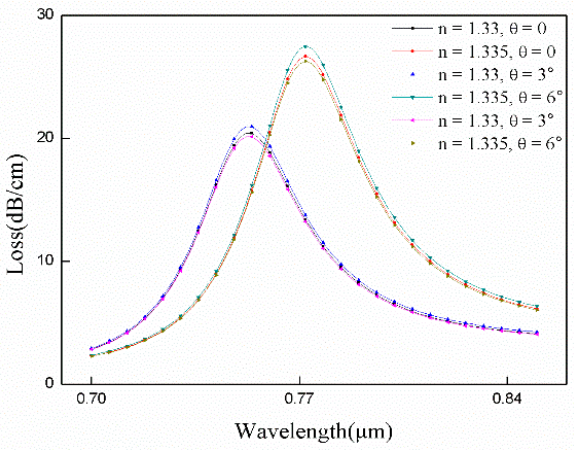
Figure 7. Loss spectra of the gold nanowires at different angles. Conditions: r a = 0.6 μ m, r b = 0.2 μ m,